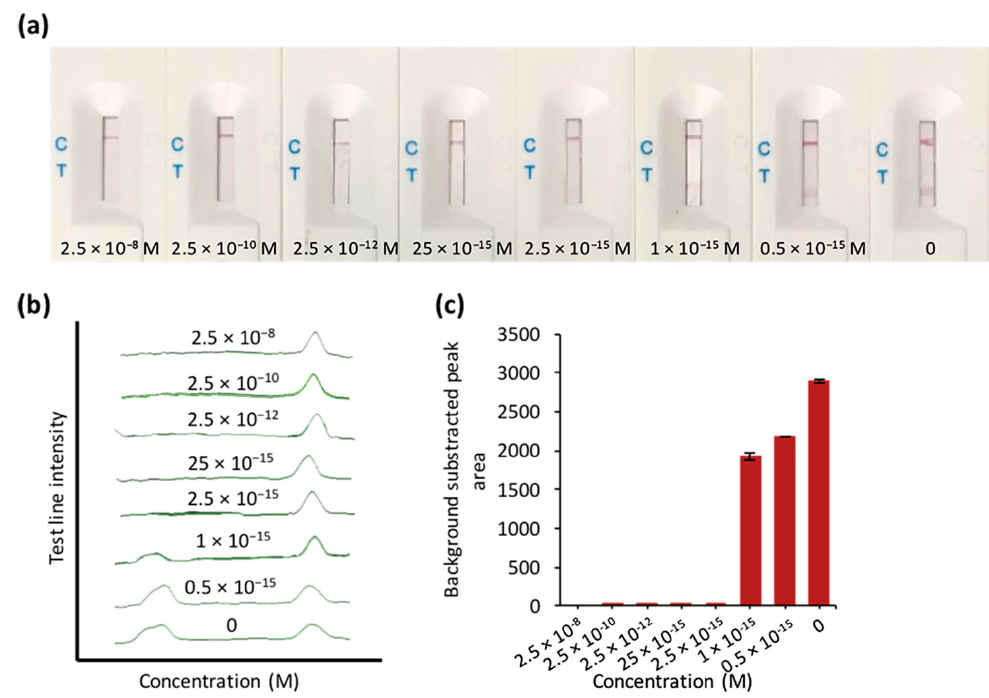
Figure 4. Evaluation of sensitivity using different concentrations of the recombinant plasmid. ( a ) LFB responses for the different concentrations. ( b ) Test and control line signal intensities. ( c ) Bar chart of the LFB test lines in ( a , b ). 0 stands for negative control.